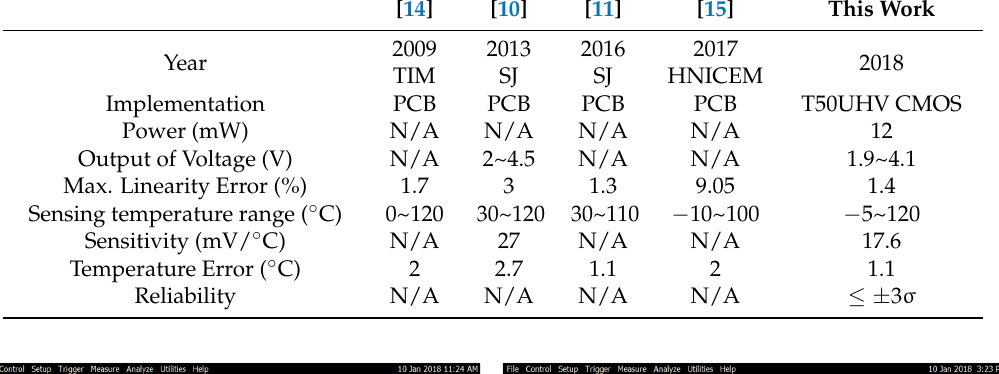
Table 2. Performance comparison of temperature sensors.